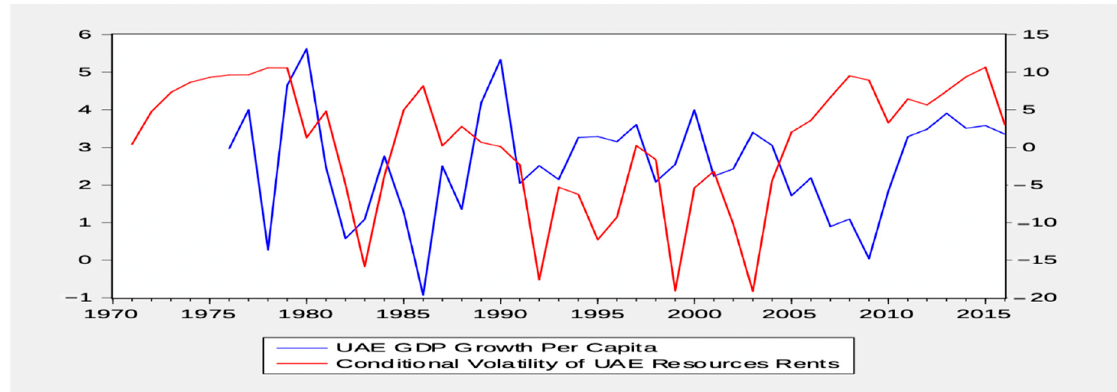
Figure A3. Conditional volatility of UAE.